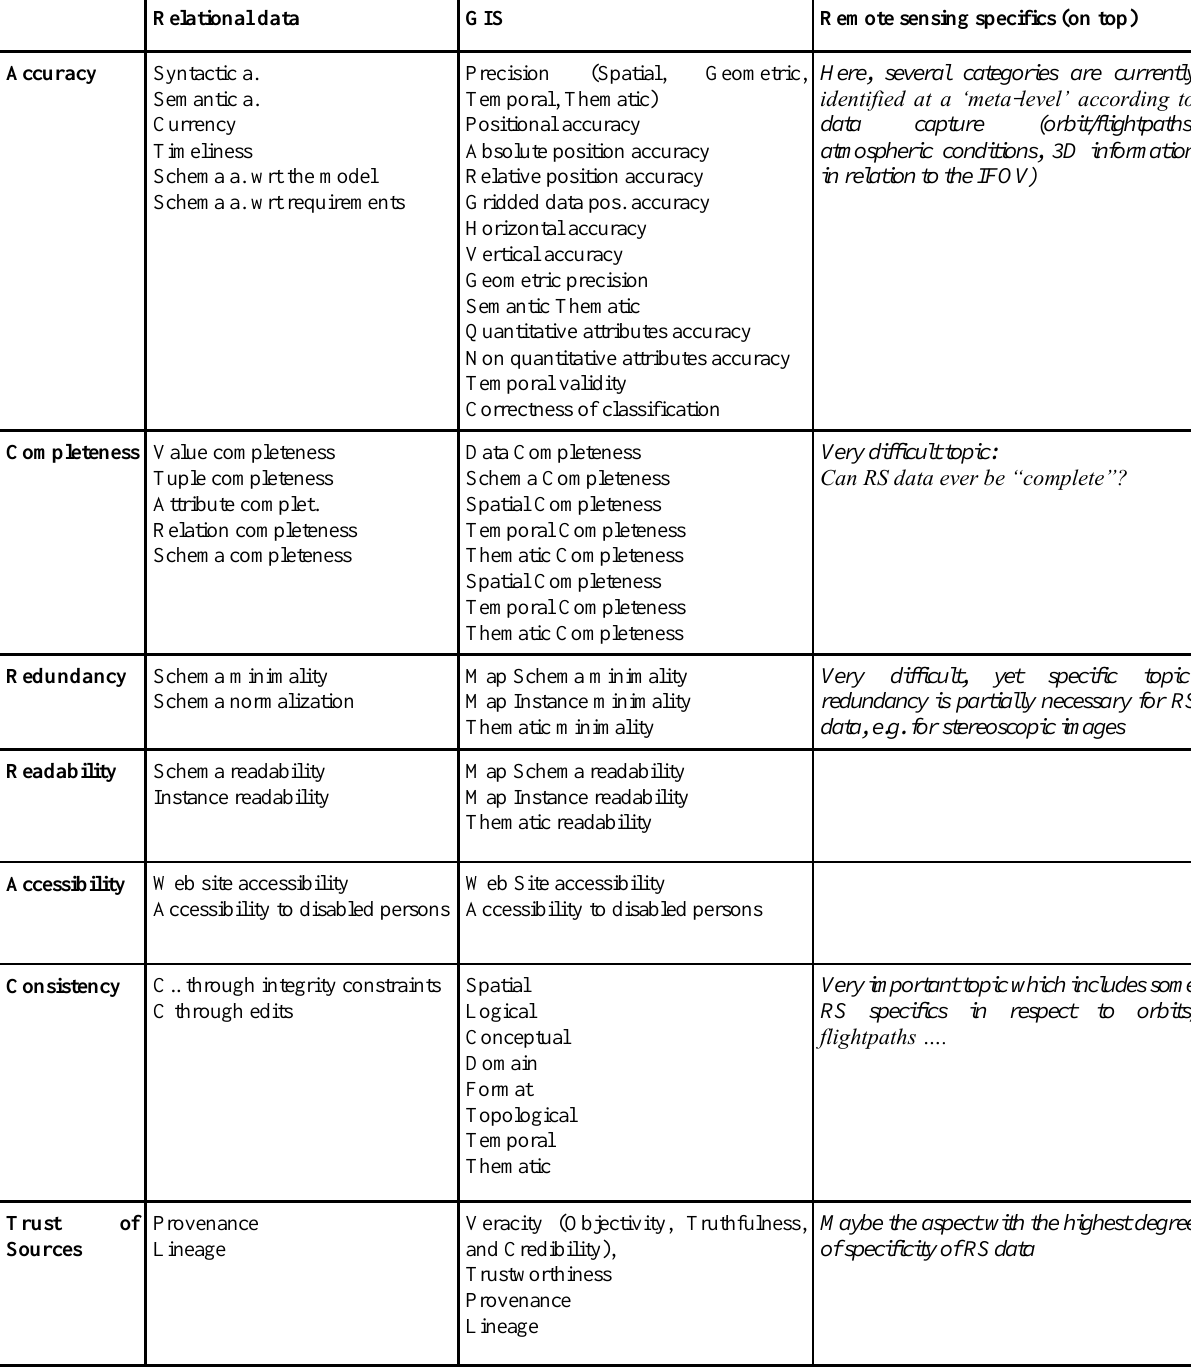
Table 1. Data Quality Dimension in GIS and RS: This table is mainly based on Batini & Scannapieco 2016. The last column is only a first and indicative version of ongoing work of this ISPRS working group and will be replaced for the final print